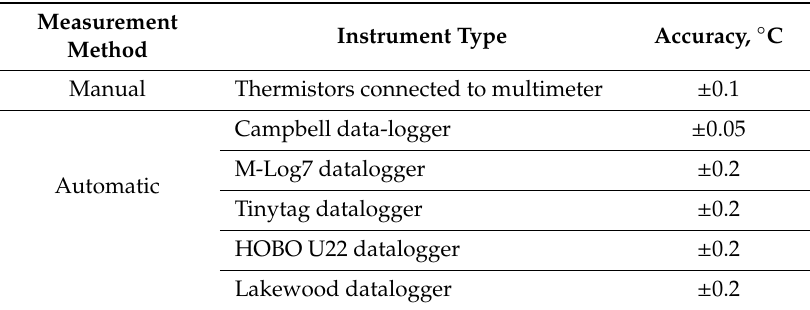
Table 1. The accuracy of the di ff erent instrument types.